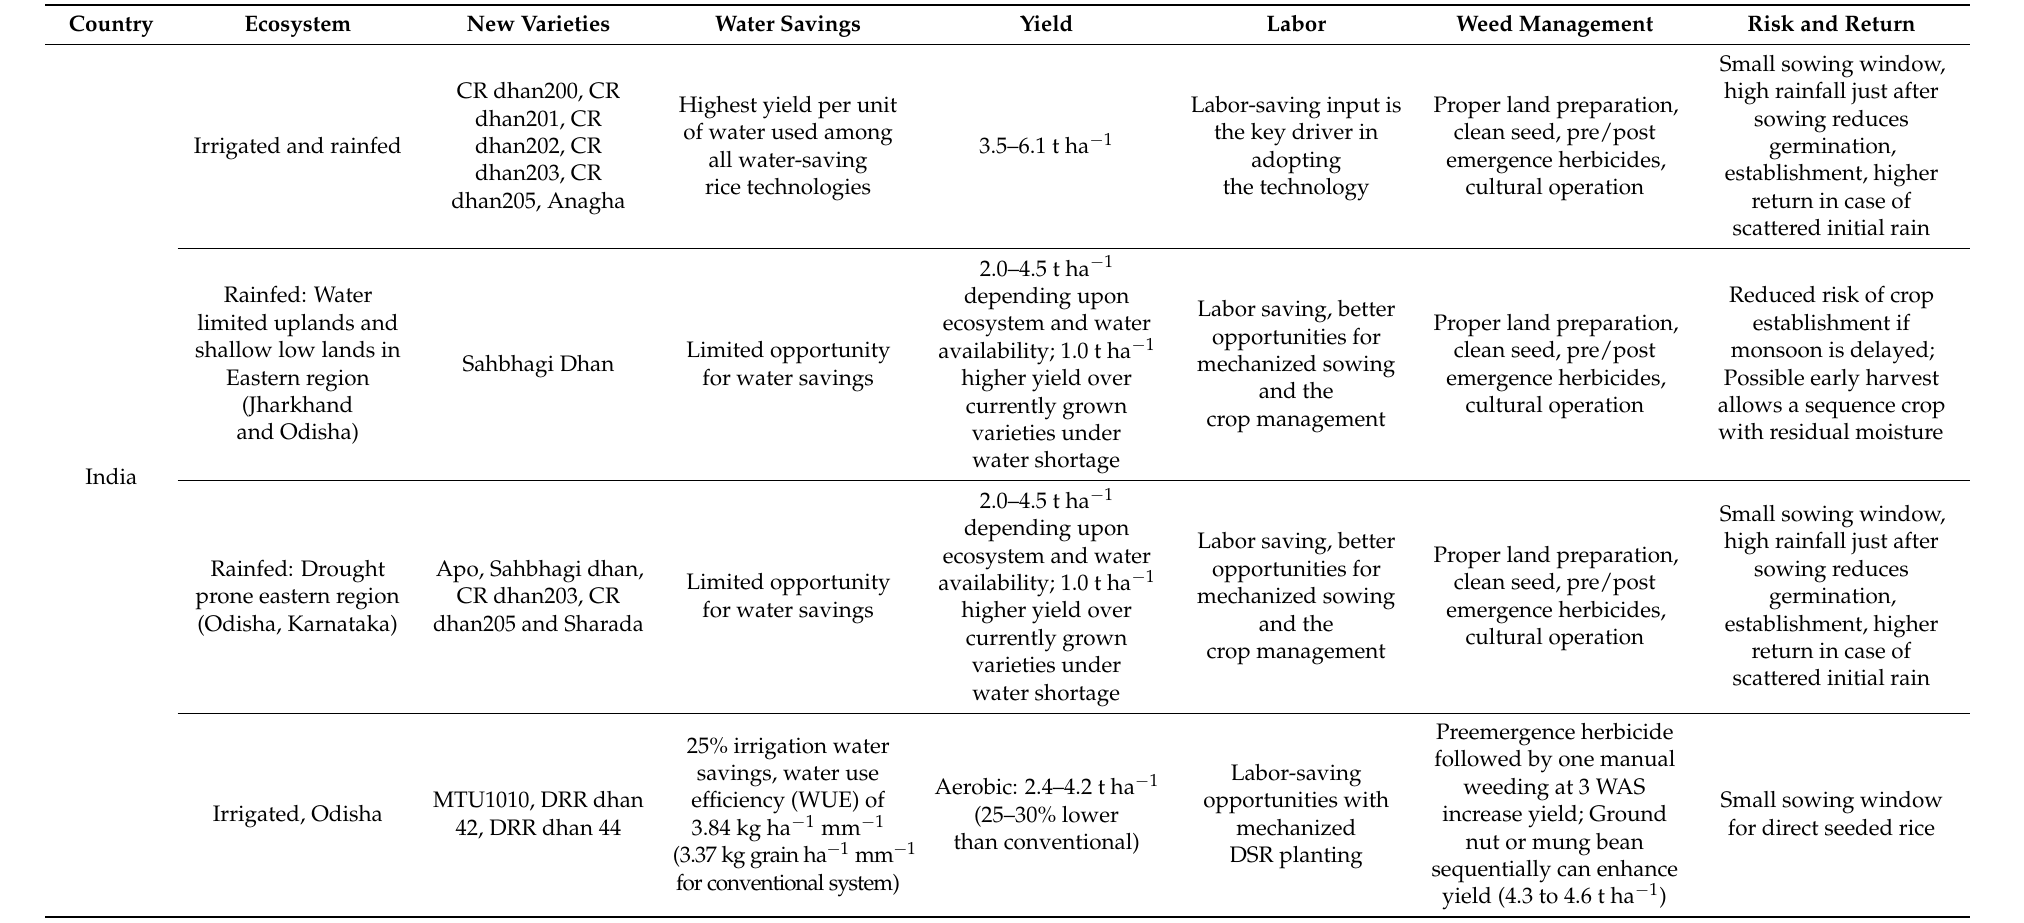
Table 5. Detailed information on varieties, required cultivation practices and their benefits and yield potential in diverse ecosystems under direct seeded rice cultivation system.